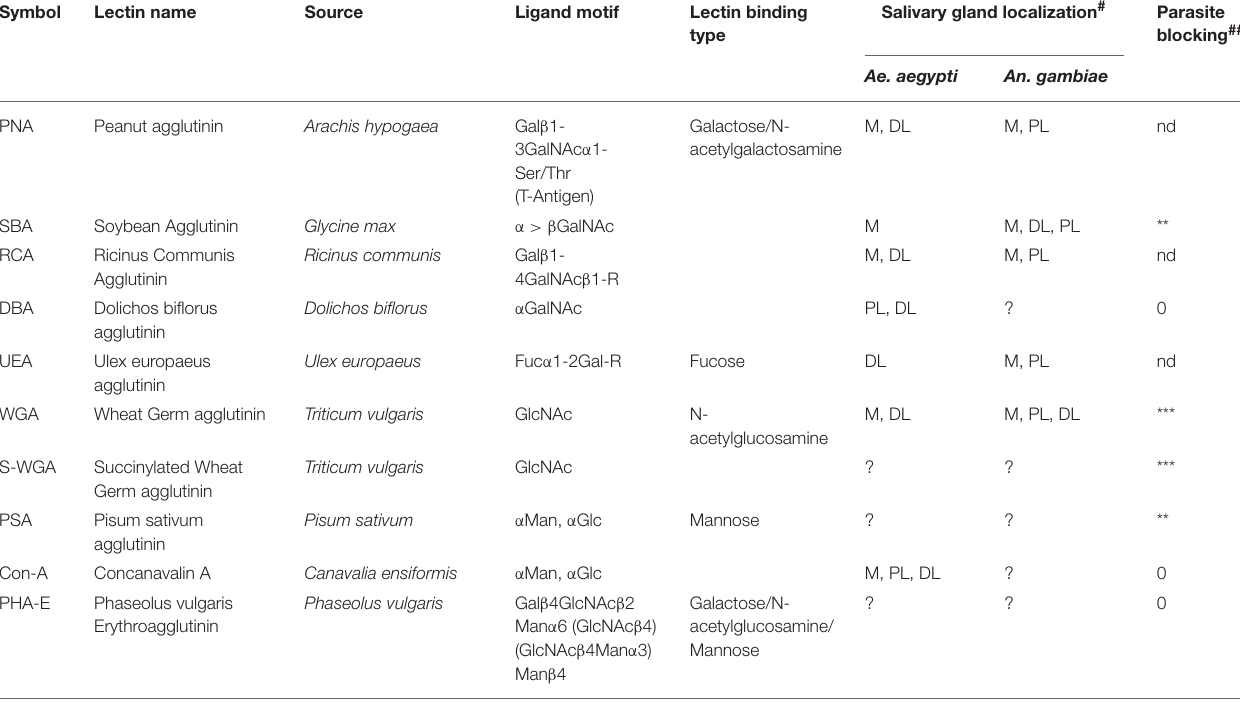
TABLE 3 | Lectins used to bind sugars on the mosquito salivary gland surface.